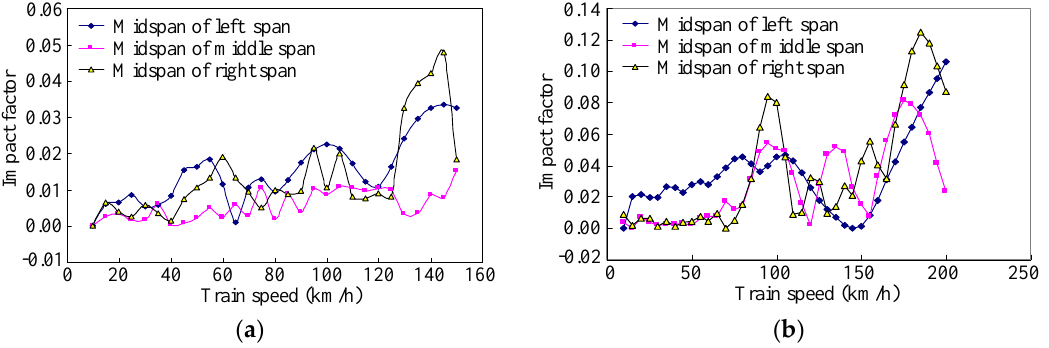
Figure 17. Impact factors calculated from deflections (track irregularity is not considered) under: ( a ) one freight train; ( b ) one passenger train.